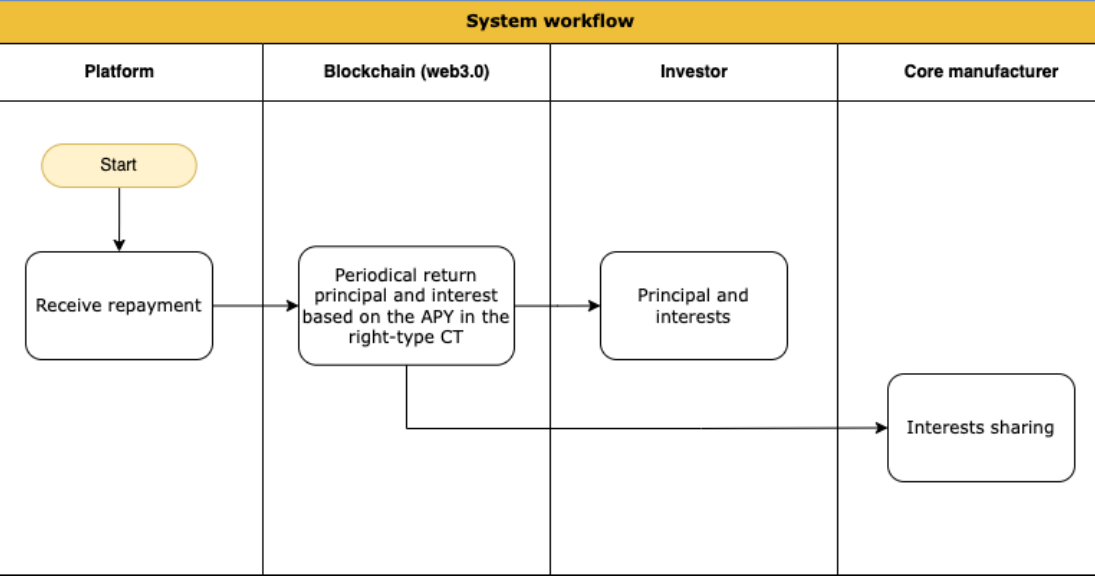
Figure 14. The workflow for profit-sharing in finance management.